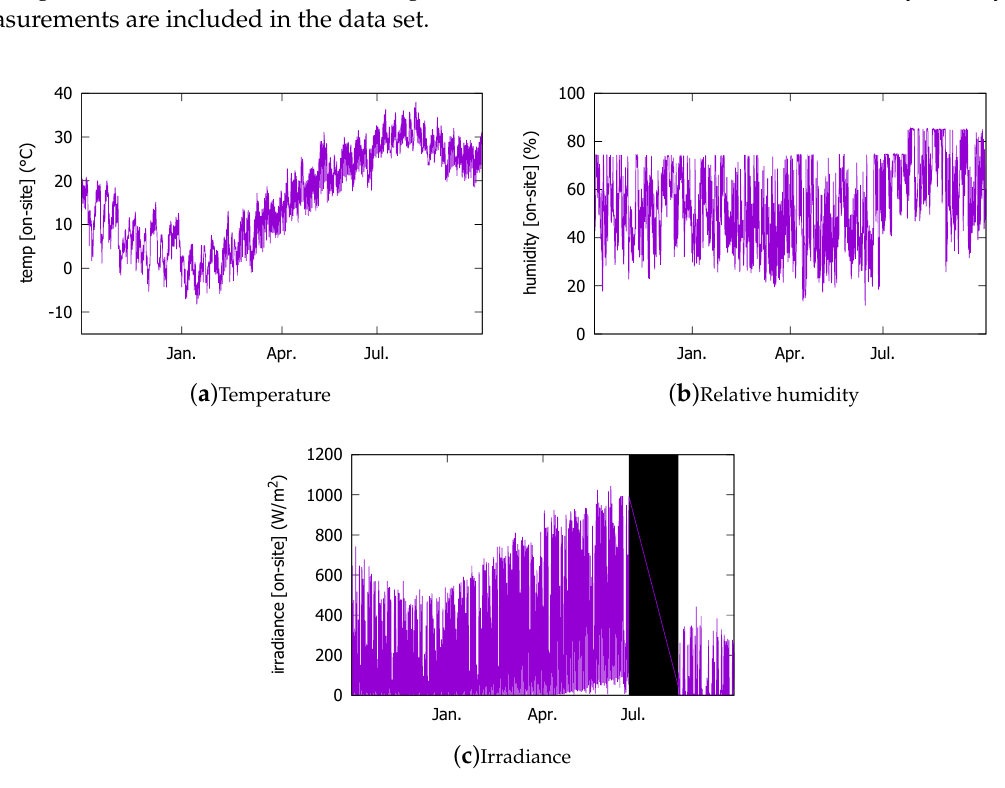
Figure 3. On-site sensory measurement data in the 2016 data